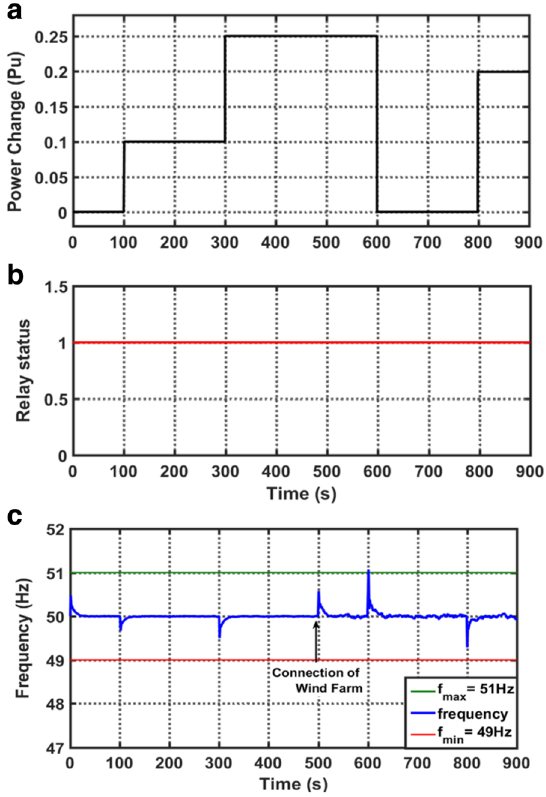
Fig. 9 Case A ( a ) Load disturbance, ( b ) Relay status, ( c ) Frequency response of